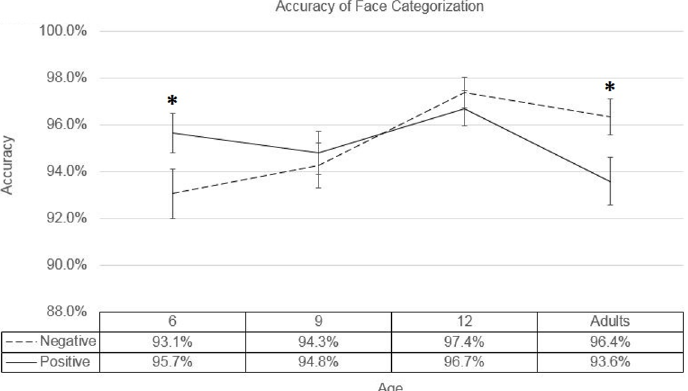
Fig 2. Measures of accuracy. Accuracy rates for categorization of positive and negative faces over all age groups. Stars indicate the significance level of differences between positive and negative faces within each corresponding age group. Error bars represent standard